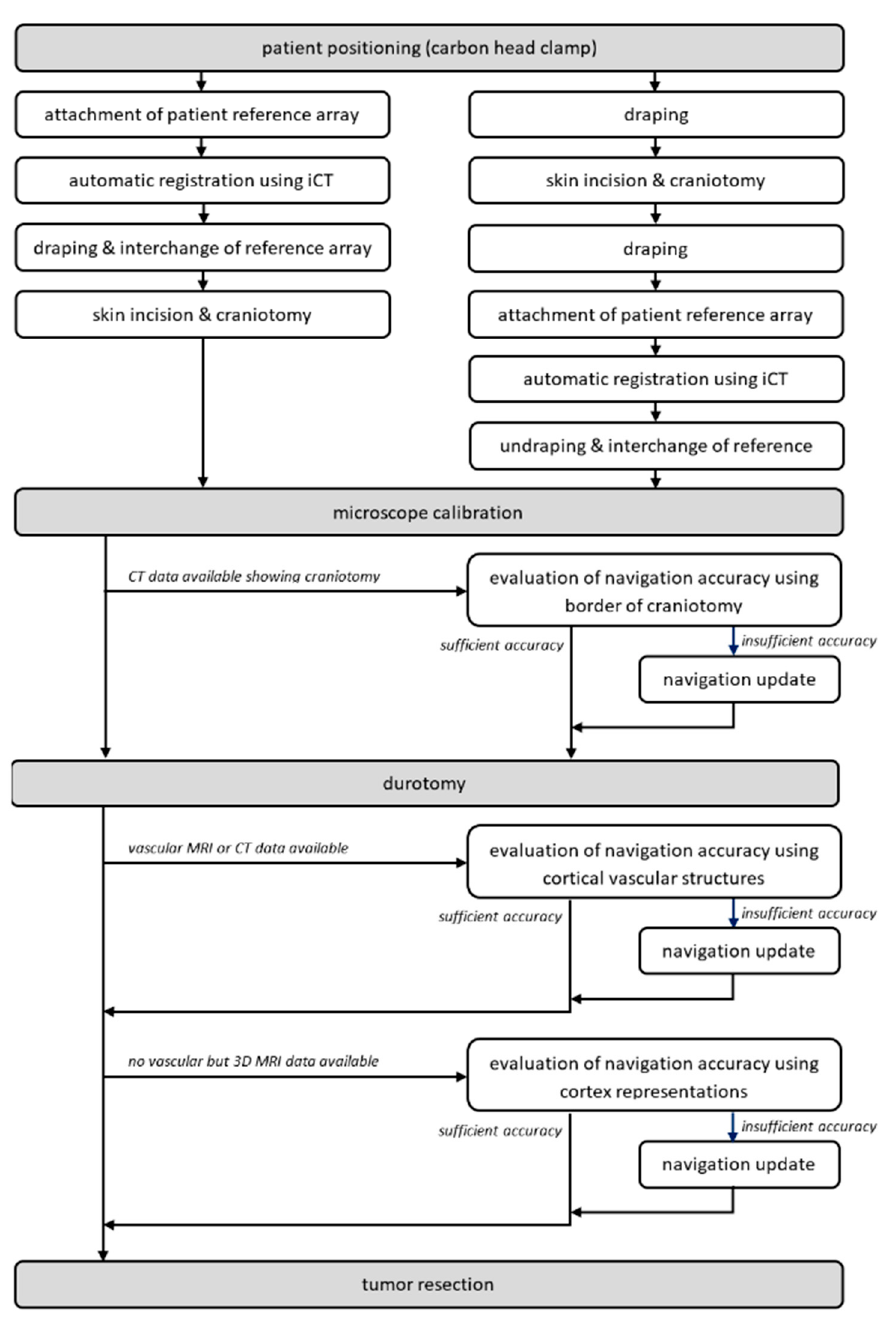
Figure 1. Overall workflow incorporating the application of automatic registration using iCT (prior to or after craniotomy), microscope calibration, AR-based navigation verification, and a potential update prior to the durotomy using bony landmarks and AR-based navigation verification, and a potential update using vascular structures and/or cortex representations depending on data availability.